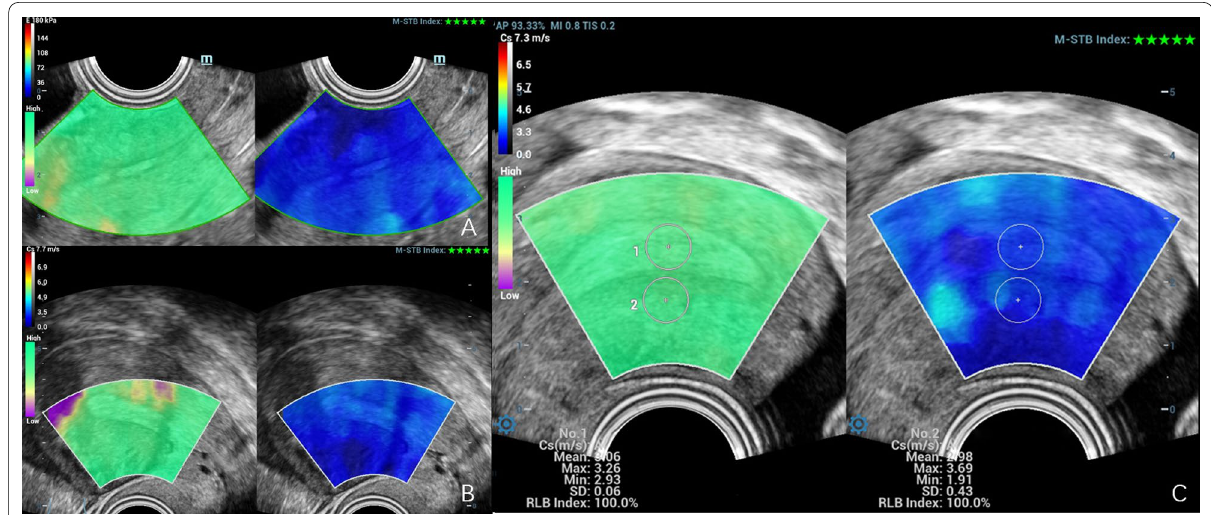
Fig. 6 SWE for normal endometrium. SWE showed a relatively uniform blue area in the proliferative endometrium ( A ) and secretory endometrium ( B ). Image C further showed that the region of interest was selected in endometrium 1 and myometrium 2 and that shear wave speed (Cs) were